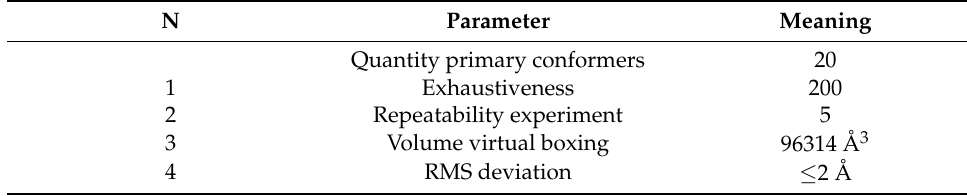
Table 1. The initial parameters of molecular